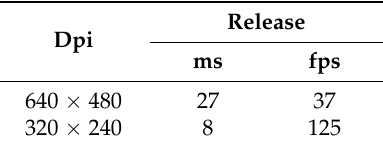
Table 3. Comparison of system execution speed at various resolutions.